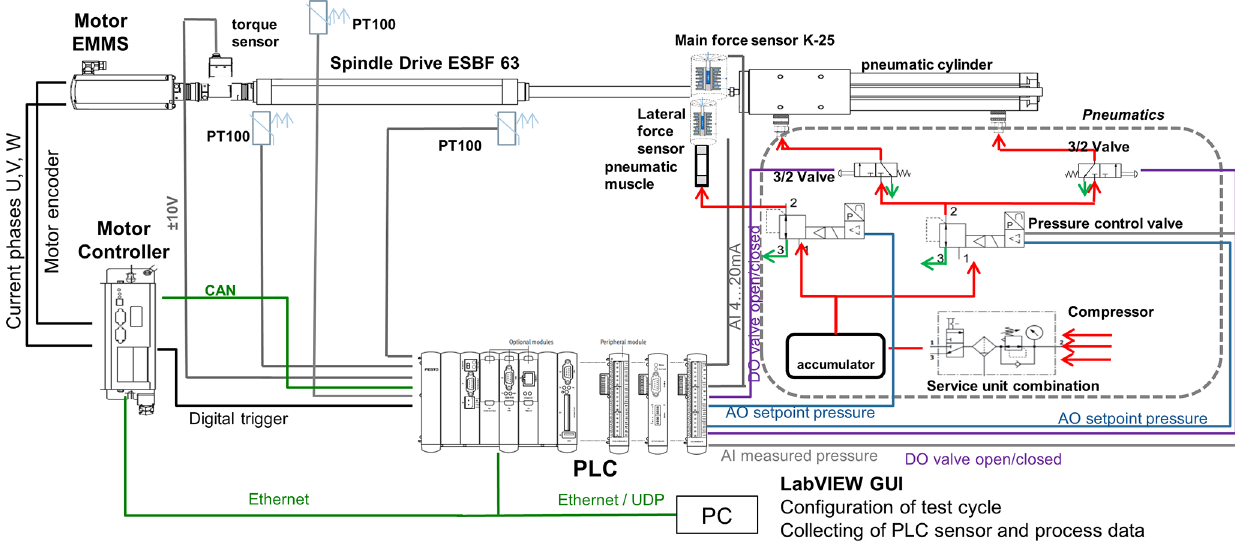
Figure 1. Basic scheme of the EMC test bed (Helwig et al., 2017).